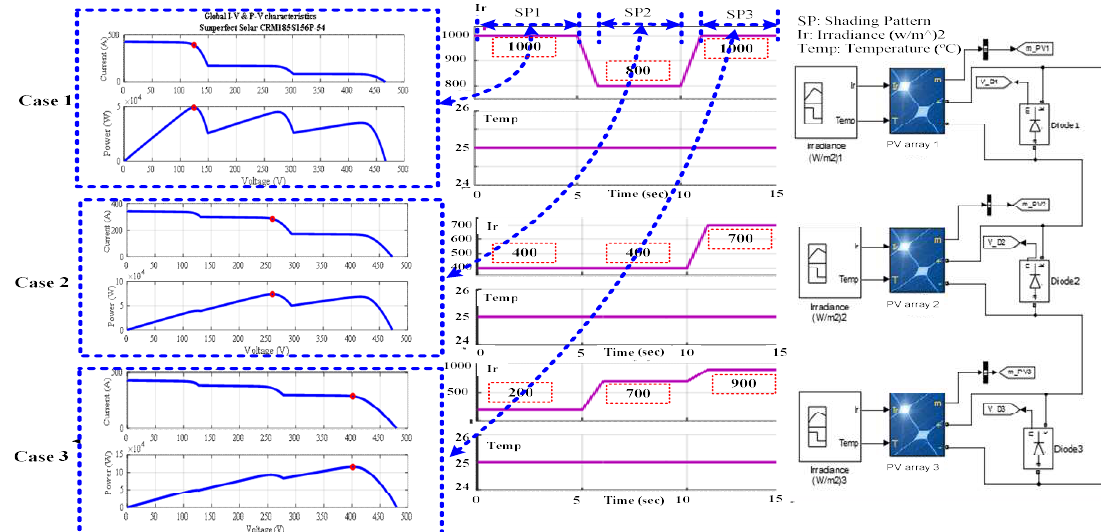
Figure 3. Three different partial shading cases of the PV arrays under study.